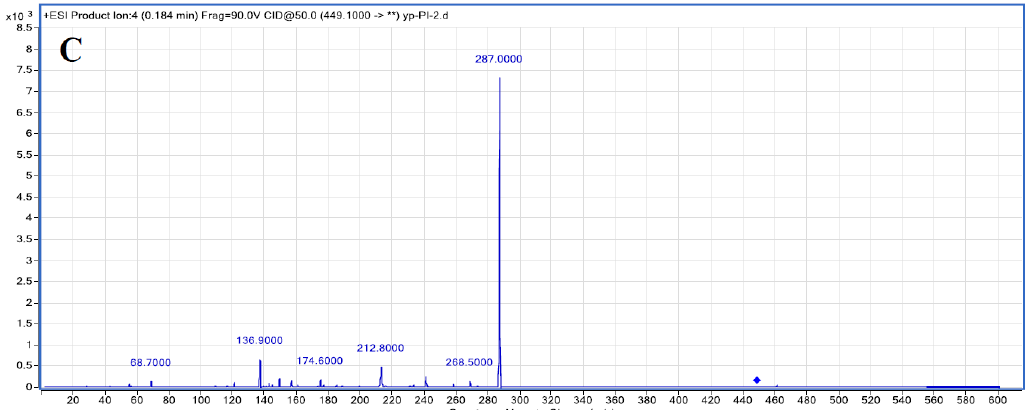
Figure 1. HPLC chromatograms of Chinese bayberry pulp ( A ) and purified C3G from Chinese bayberry ( B ) ( λ = 280 nm) and LC-MS 2 spectrum of purified C3G ( C ).